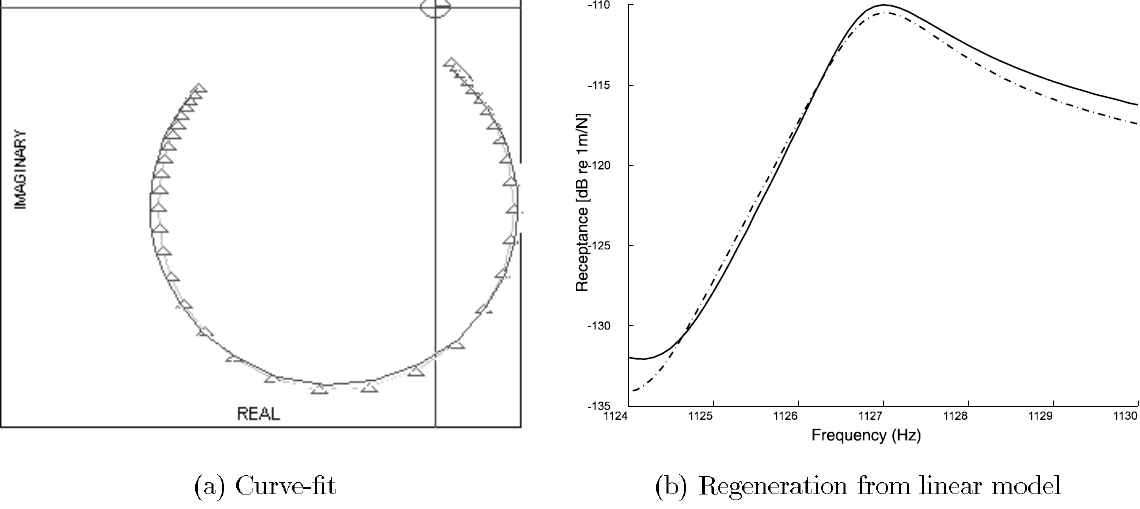
Fig. 11. Linear modal analysis of non-linear response: Original response, ... Regeneration with linear modal